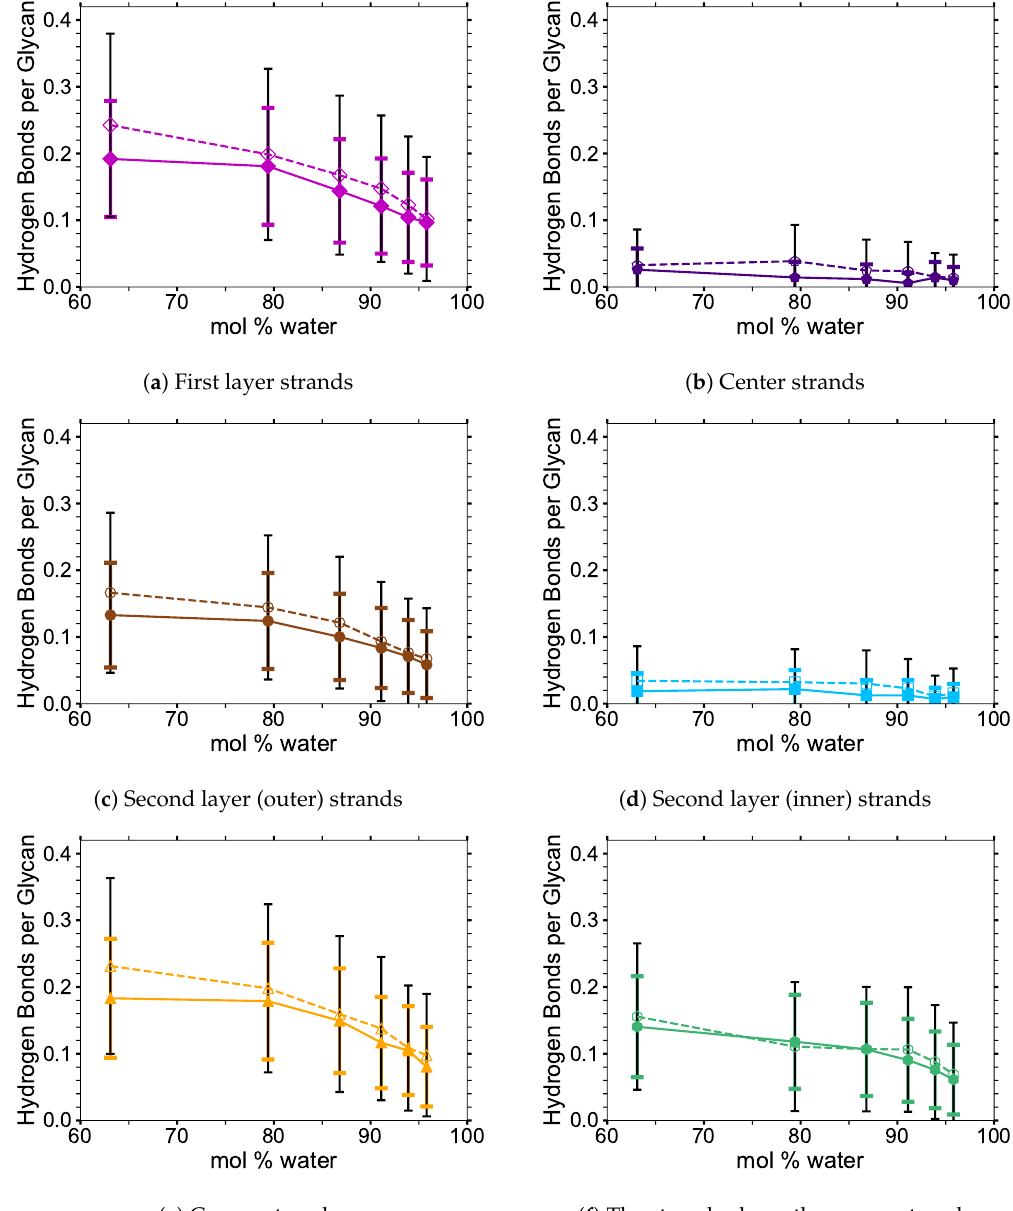
Figure A4. Average TBP-strand hydrogen bonding comparison with standard deviations between the small and large cellulose bundles at various water concentrations: ( a ) the first layer strands; ( b ) the center strands; ( c ) the second layer (outer) strands; ( d ) the second layer (inner) strands; ( e ) the corner strands; ( f ) the strands above the corner strands. All data points were averaged from 10 to 20ns. The solid lines, filled markers, and colored error bars represent the large cellulose bundle, and the dashed lines, unfilled marker, and black error bars show the small cellulose bundle. The colored strands are matched and compared between the plots for the small and large bundles and the images to identify similar hydrogen bonding behavior based on their locations (see Figure 6a,b for the color-coded images). The black cellulose strands are not